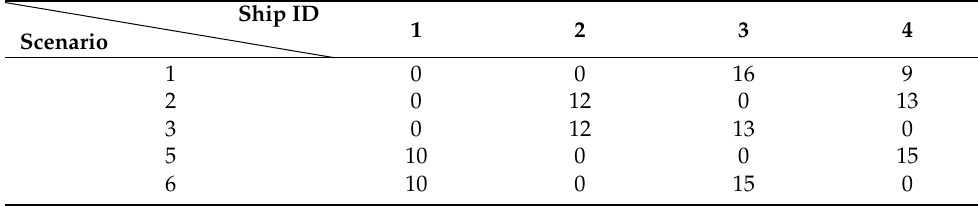
Table 5. Example 1—final results of the allocation (m 3